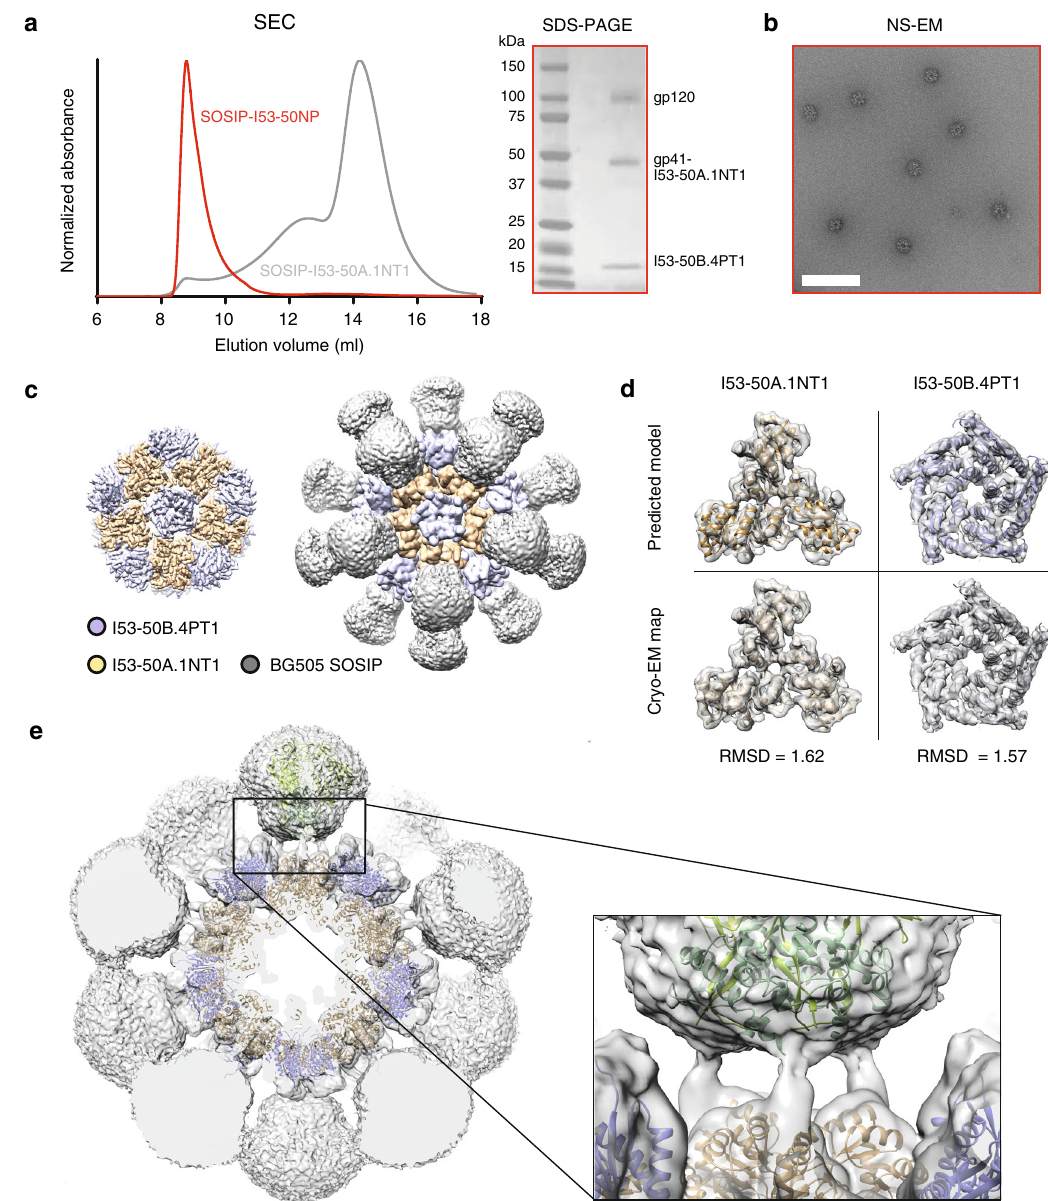
Fig. 2 Characterization of BG505 SOSIP-I53-50NP assembly and cryo-EM structure. a Representative SEC chromatogram (left) of assembled BG505 SOSIP-I53-50NP (red) overlaid with BG505 SOSIP-I53-50A.1NT1 (gray) and reducing SDS-PAGE (right) of pooled BG505 SOSIP-I53-50NP fractions. b Raw NS-EM micrograph of pooled fractions corresponding to BG505 SOSIP-I53-50NPs. The white bar corresponds to 200 nm. c Segmentation of the sharpened cryo-EM map at high contour level showing details of NP core (left) and Gaussian fi ltered map at low contour levels showing poorly resolved SOSIP trimers (right). d Details of I53-50A.1NT1 (left) and I53-50B.4PT1 (right) showing the predicted model (top) and cryo-EM map (bottom). Root- mean-square deviation (RMSD) are shown below each component. e Low-pass- fi ltered cyro-EM map and pseudo-atomic model of BG505 SOSIP-I53- 50NP with detail of the linker separating I53-50A.1NT1 and BG505 SOSIP. Source data are provided as a Source Data fi